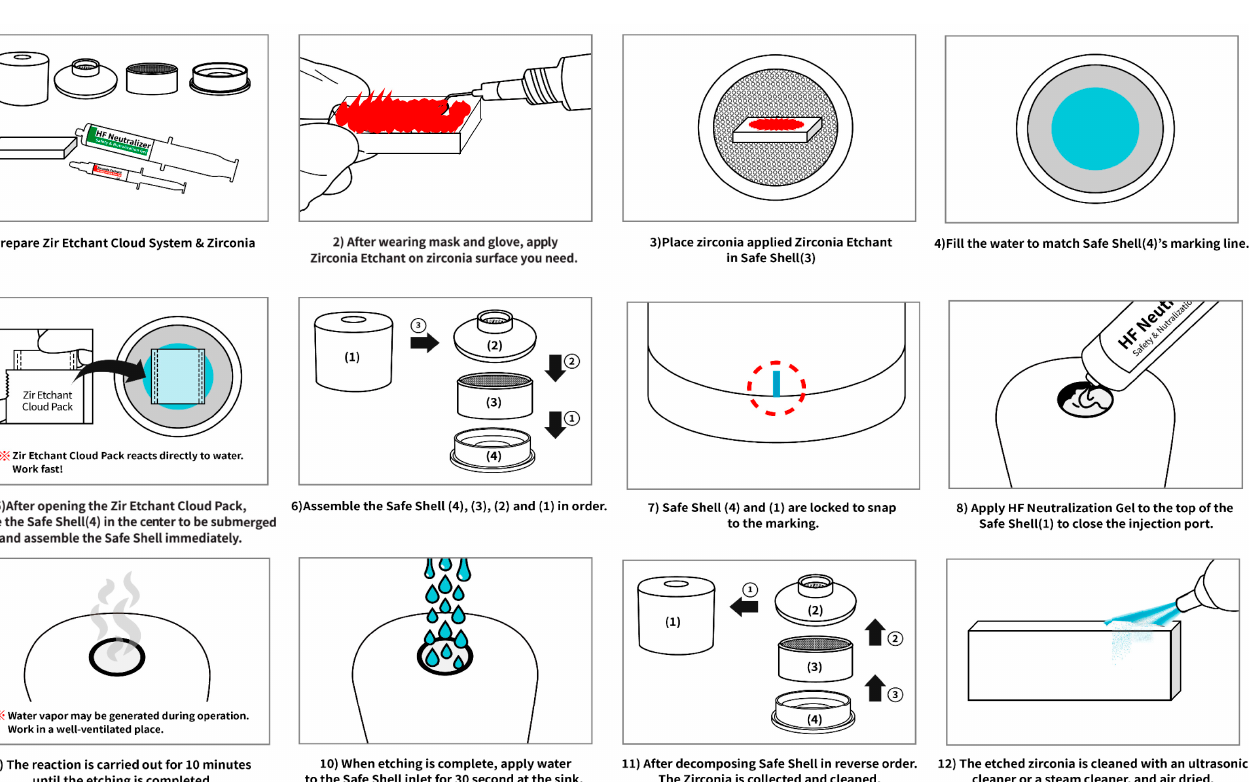
Figure 2. Schematic diagram of experimental grouping. A uniformly sized cement adhesive area was obtained by attaching a 3M Scotch brand tape to a zirconia specimen. The tape had a thickness of approximately 50 μ m, with three holes of 2 mm in diameter spaced at regular intervals. Then, polytetrafluoroethylene (PTFE) tubes (internal diameter: 4 mm; external diameter: 6 mm; height: 5 mm) were placed on the adhesive area and filled with resin cement to create cement cylinders 4 mm